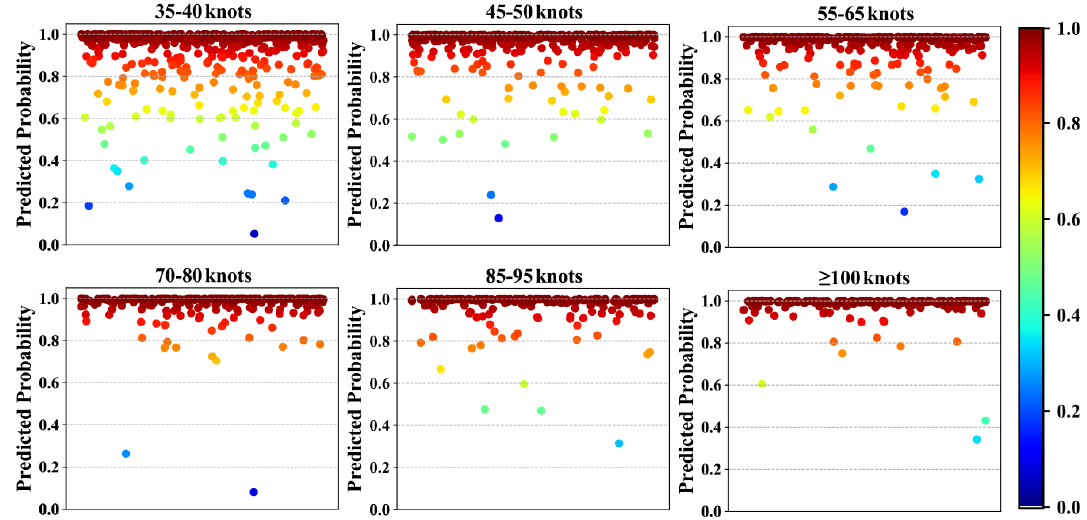
Figure 17. Prediction probability for NWPO images involving a single TC stratified by TC intensity.